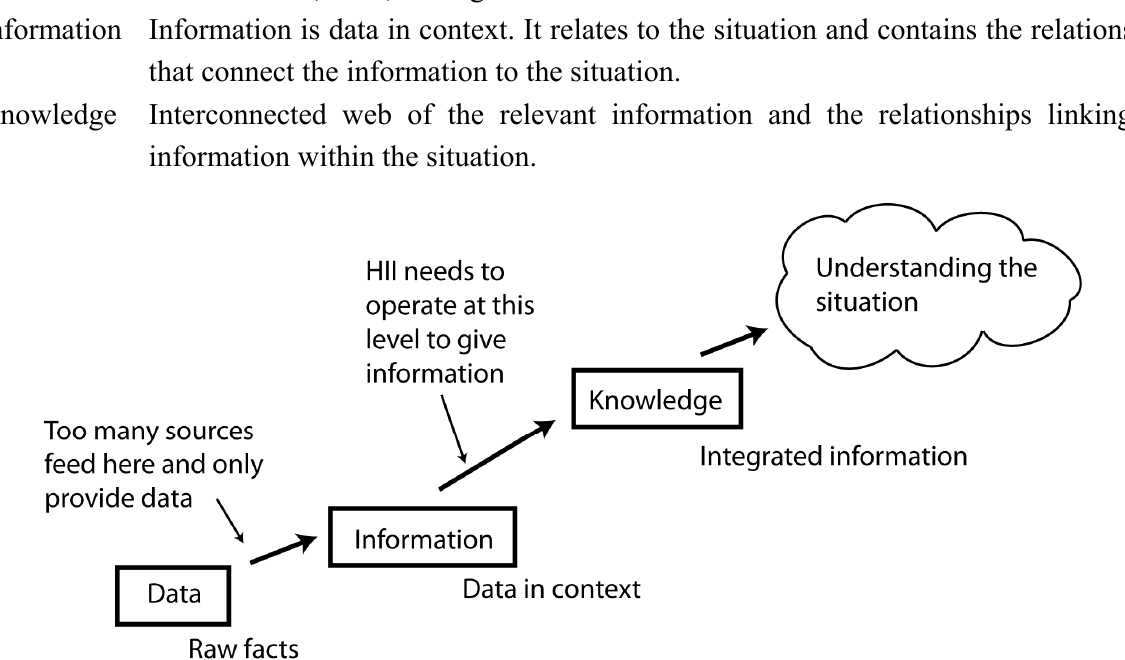
Figure 3. Data, information, and knowledge hierarchy. The higher the HII works in the hierarchy, the better it fits building an understanding of the